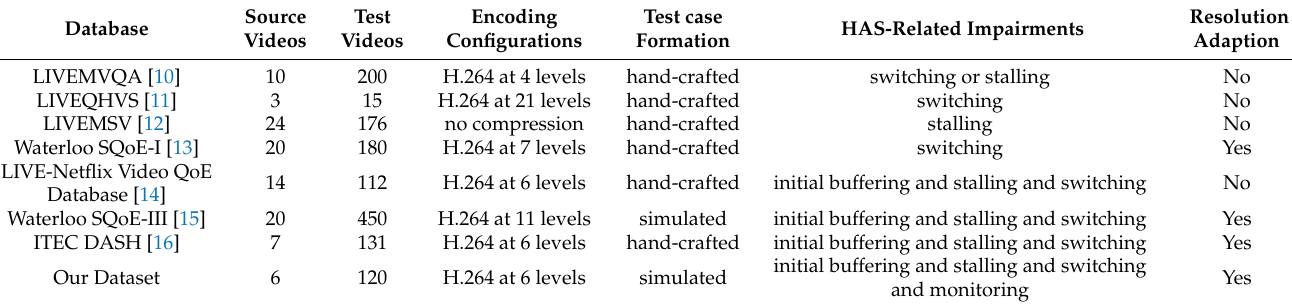
Table 1. Comparison of publicly available QoE dataset for HTTP-based adaptive video